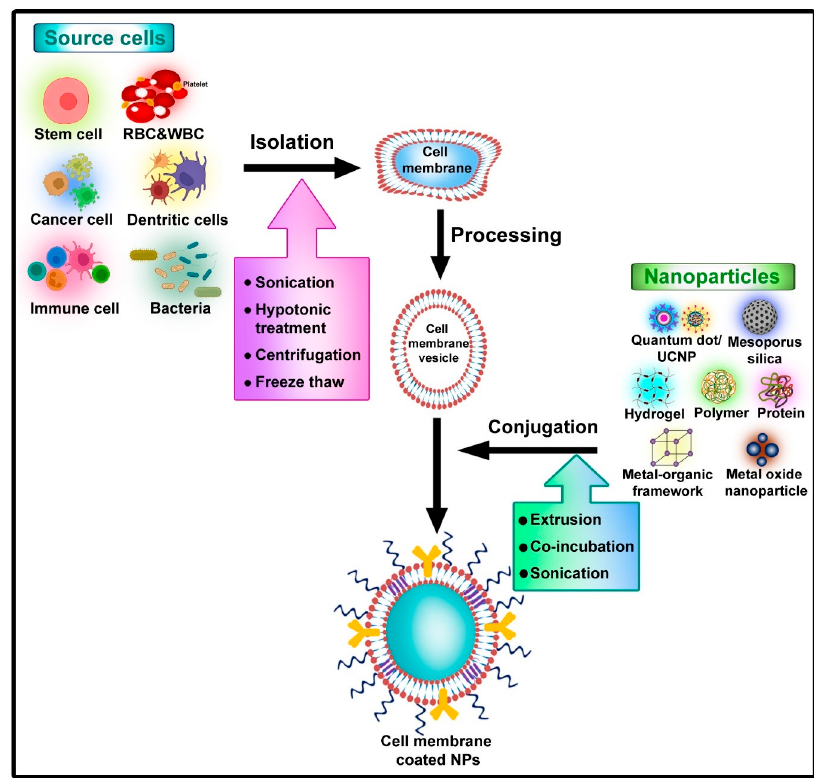
Figure 1. Method of fabrication of